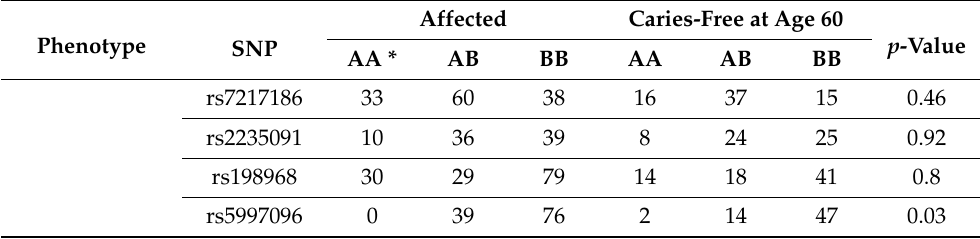
Table 3. Genotyping distribution per tested